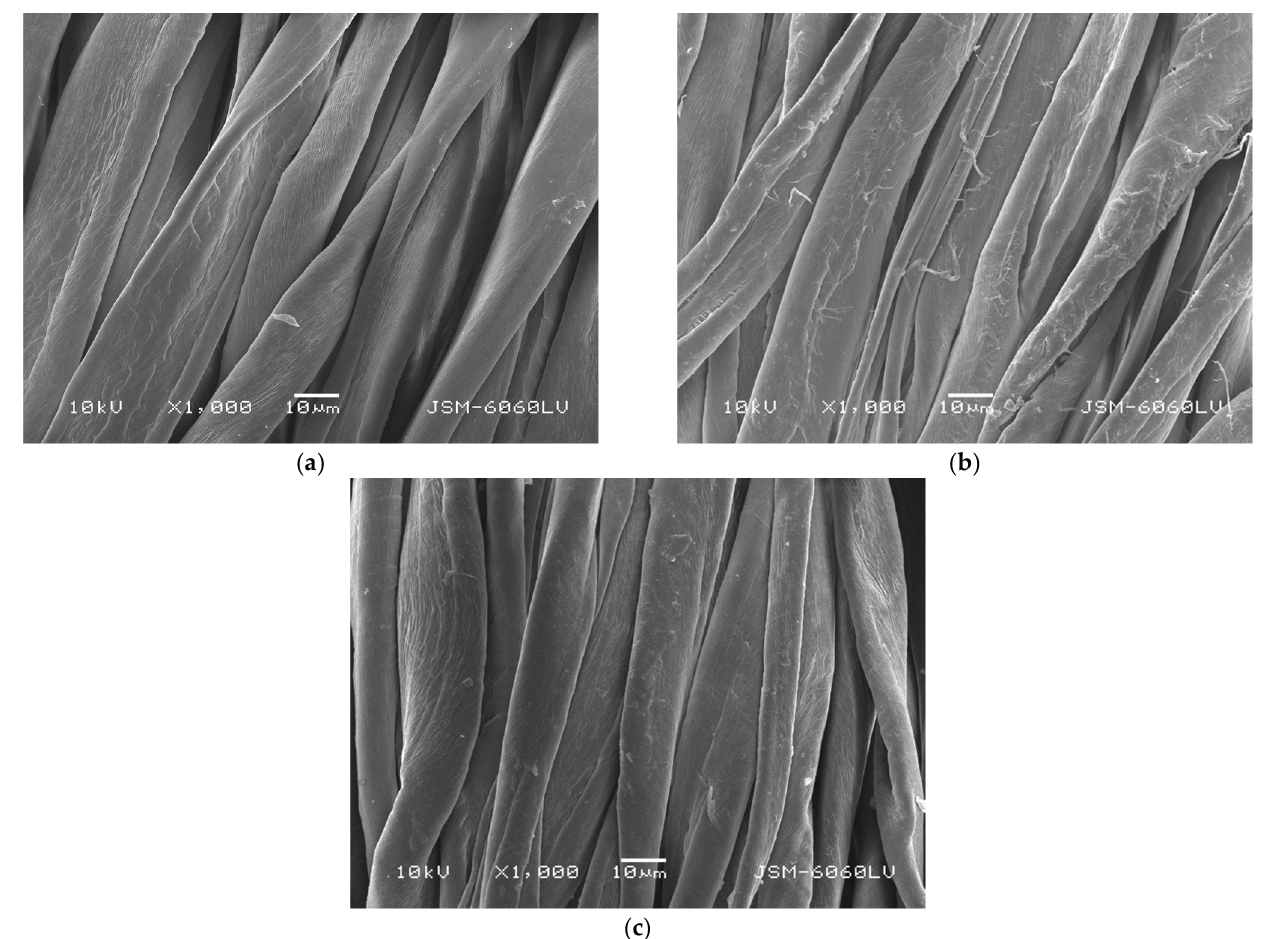
Figure 2. SEM images of ( a ) untreated, ( b ) O 2 plasma-treated, and ( c ) N 2 plasma-treated samples of cotton fabric.